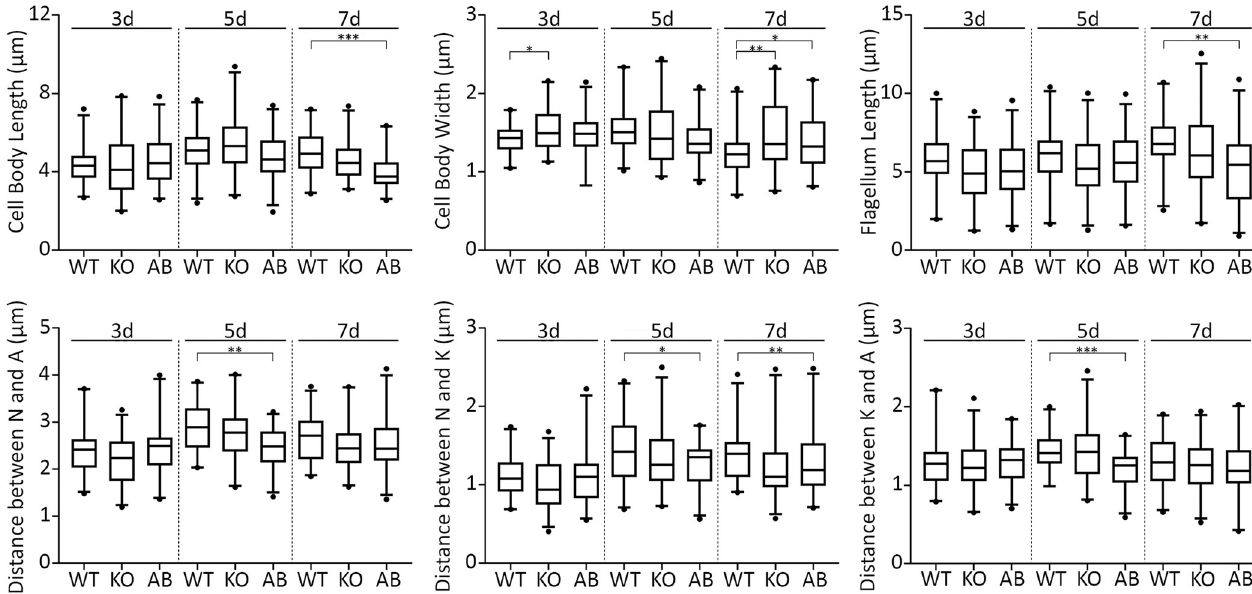
Fig 3. Morphometric analysis of L . guyanensis with ablated Lg PAP2L in vitro for days 3, 5, and 7 of cultivation. A, anterior end of the cell; K, kinetoplast; N, nucleus. Boxes and error bars indicate the median along with the upper and lower quartiles, and 97.5 percentiles, respectively. Asterisks show significant differences ( � – P � 0.05; �� – P � 0.01; ��� – P � 0.001), no other differences were statistically significant.